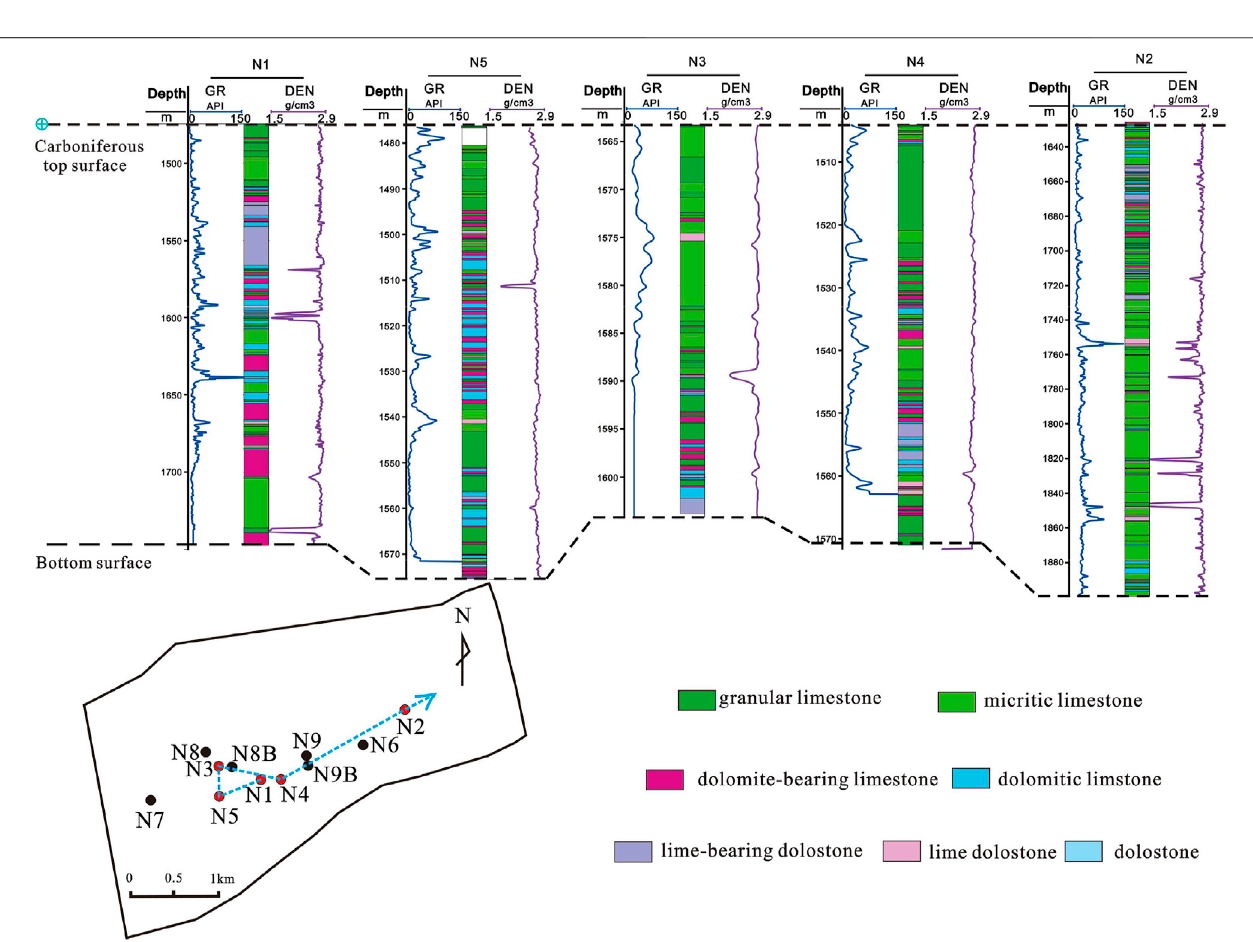
FIGURE 4 | Lithology division and comparison diagram of Weizhou 1 – N oil fi eld.